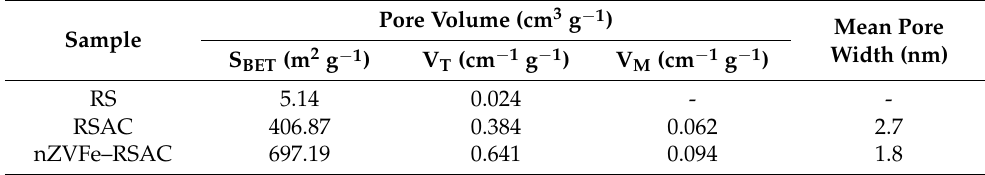
Table 3. Textural characterization of the RS, RSAC, and nZVFe–RSAC